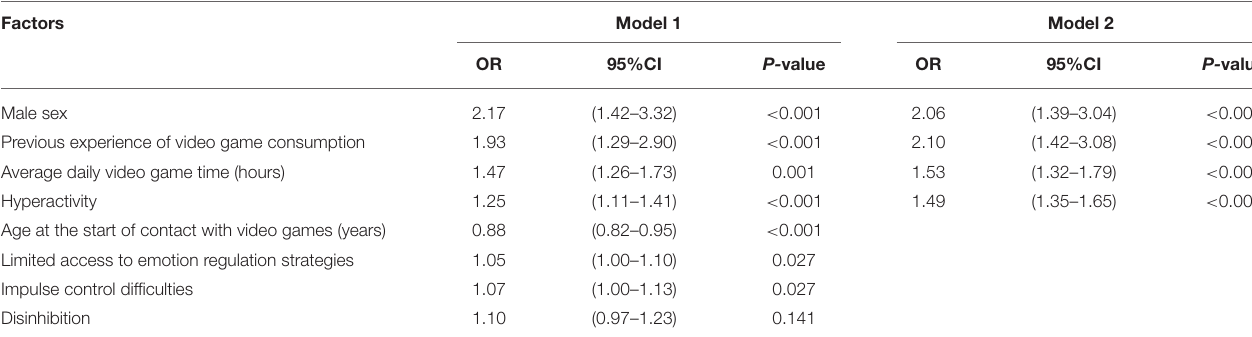
TABLE 2 | Risk factors for IGD identified by multivariable logistic analysis.